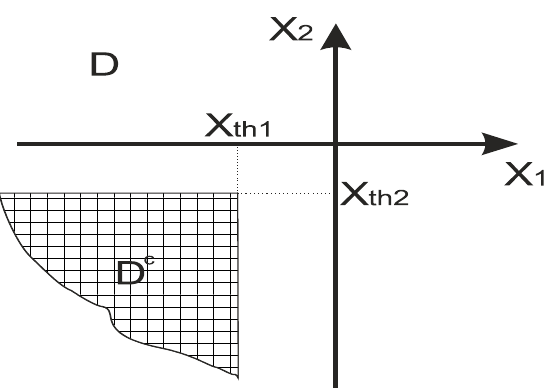
Figure 1. Shaded area of outage for a dual-diversity scheme for selection combining (SC) method.